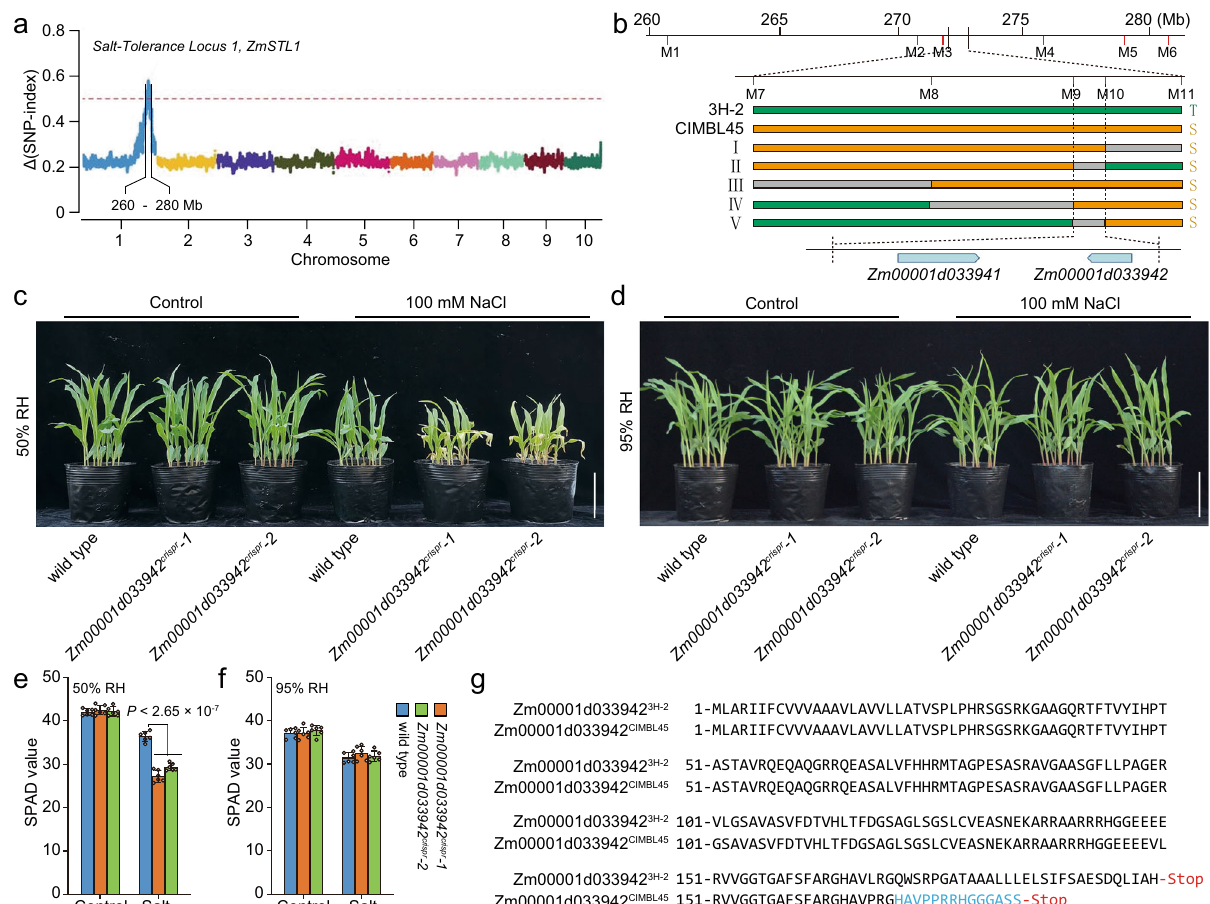
1-MLARIIFCVVVAAAVLAVVLLATVSPLPHRSGSRKGAAGQRTFTVYIHPT 1-MLARIIFCVVVAAAVLAVVLLATVSPLPHRSGSRKGAAGQRTFTVYIHPT 51-ASTAVRQEQAQGRRQEASALVFHHRMTAGPESASRAVGAASGFLLPAGER 51-ASTAVRQEQAQGRRQEASALVFHHRMTAGPESASRAVGAASGFLLPAGER 101-VLGSAVASVFDTVHLTFDGSAGLSGSLCVEASNEKARRAARRRHGGEEEE 101-GSAVASVFDTVHLTFDGSAGLSGSLCVEASNEKARRAARRRHGGEEEEVL 151-RVVGGTGAFSFARGHAVLRGQWSRPGATAAALLLELSIFSAESDQLIAH-Stop 151-RVVGGTGAFSFARGHAVPRGHAVPPRRHGGGASS-Stop Fig. 2 The dirigent family gene Zm00001d033942 is the candidate of ZmSTL1 . a BSA-based analysis mapped ZmSTL1 to a 20-Mb region on Chromosome 1 (see methods). ( b ) High-resolution linkage assay mapped ZmSTL1 to a 110-kb region (see “ Methods ” ). The graphical genotypes of fi ve important recombinants were shown. Green, gray and yellow bars represented regions homozygous for 3H-2, regions with undetermined genotypes, and regions homozygous for CIMBL45, respectively. The two genes within the 110-kb candidate region were shown. c – f The appearances ( c , d ) and SPAD values ( e , f ) of Zm00001d033942 crispr and wild- type plants grown under control and salt (100mM NaCl) conditions with indicated relative humidity (RH). g Alignment of the amino acid sequences of Zm00001d033942 3H-2 and Zm00001d033942 CIMBL45 . The frameshifted sequence of Zm00001d033942 CIMBL45 was highlighted in blue. The results in ( e ) and ( f ) were means±s.d. of three independent experiments. Statistical signi fi cance was determined by a two-sided t -test. Bars in ( c ) and ( d ), 10cm. Source data are provided as a Source Data fi